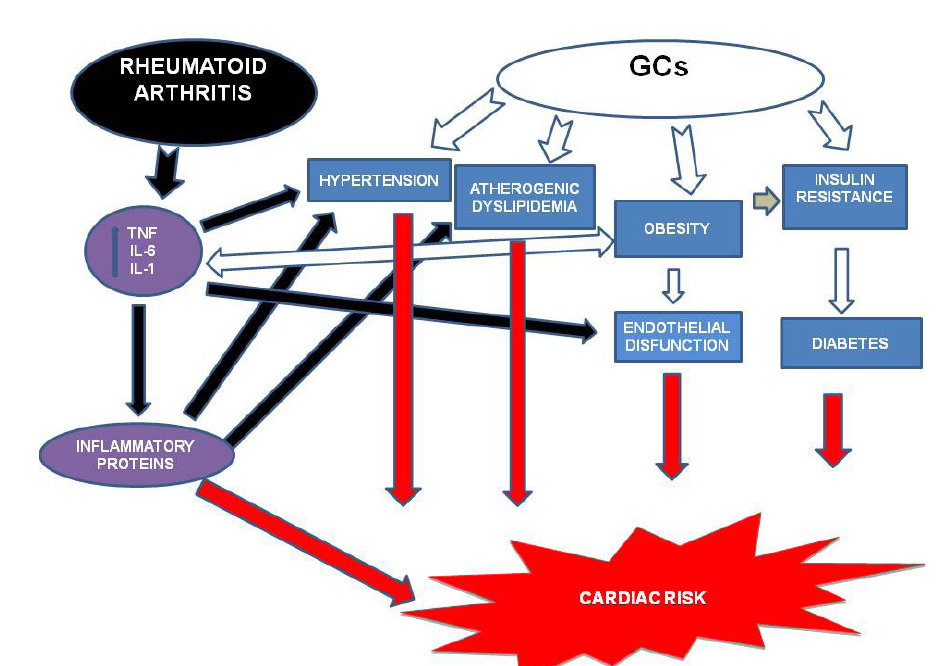
FIGURE 1 – Graphical abstract of RA and GCs mechanisms for predisposing the increase of CVR. Note: RA is a factor that induces cytokines and proinflammatory proteins; the effects of GCs on blood pressure, insulin resistance, lipid profile, body weight and fat distribution can significantly increase the risk of CVD in patients with RA. Figure 1 illustrates the different ways in which RA and the use of GCs can act on the predisposing factors to CVR (red arrows). The initial point of the RA process is the activation of the production of TNF, IL6 and IL1. The relationship between CGs and the factors predisposing to RCV are directly or indirectly indicated. In some situations there is an interaction between factors which are triggered by the disease and the